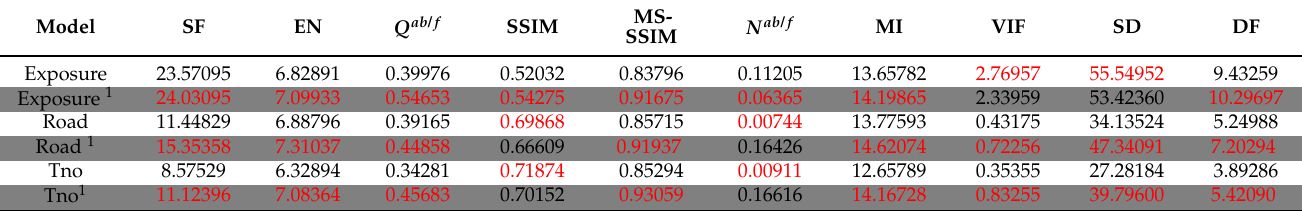
Table 6. The result of ablation